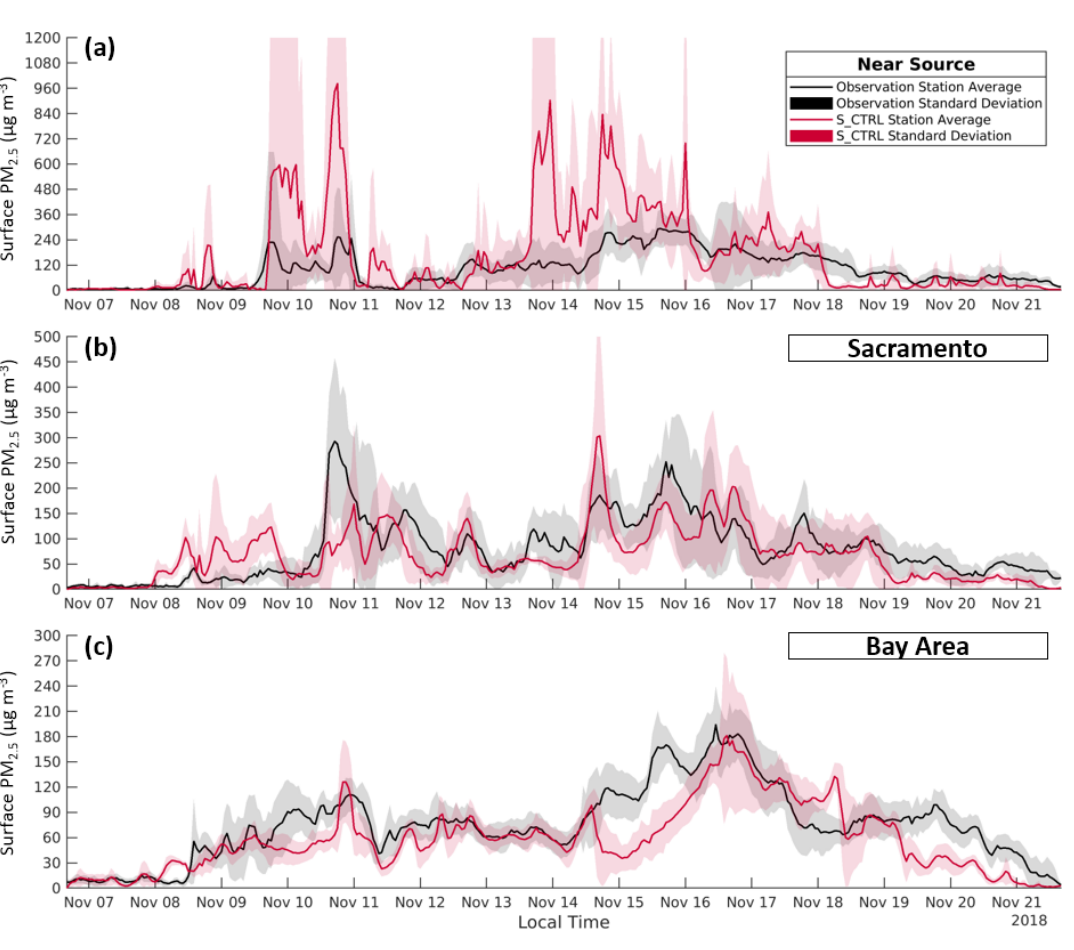
Figure 6. Comparison of AQS surface PM 2 . 5 observations (black) with S_CTRL predictions (red) averaged over the three areas of study: (a) near the wildfire ( N = 5), (b) Sacramento ( N = 7), and (c) the Bay Area ( N = 13). Shading indicates the standard deviation of the sampled stations. S_CTRL overpredicted PM 2 . 5 in the region in the vicinity of the fire but performed well in the areas